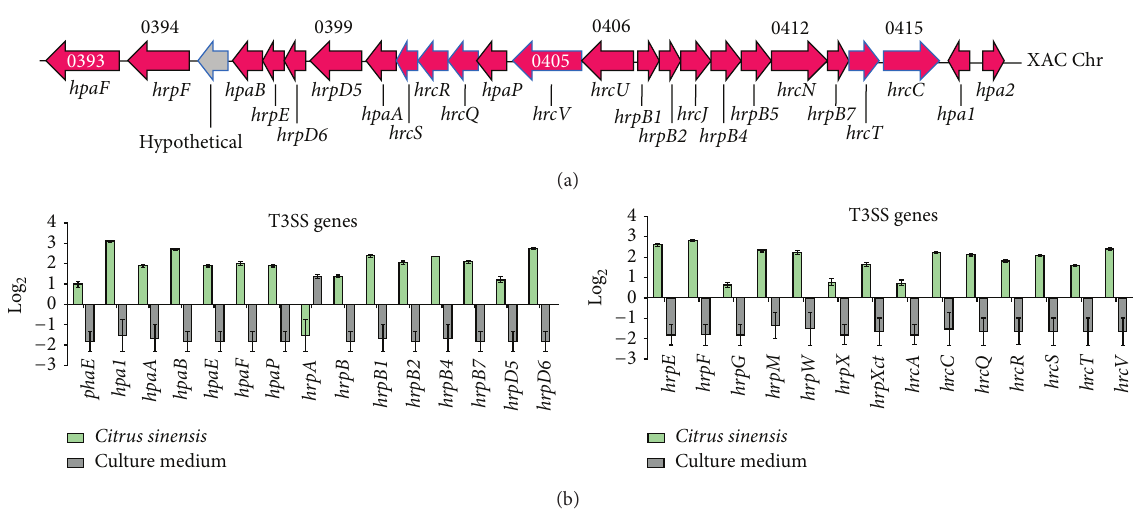
Figure 1: T3SS genes in Xanthomonas citri subsp. citri and their expression levels. Schematic representation of T3SS genes in Xanthomonas citri subsp. citri and their expression levels. (a) shows functional maps of T3SS genes on the chromosome. The expression levels of genes in the T3SS (b) are indicated. Solid green bars indicate in vivo expression with respect to their expression in vitro (black bars). Error bars indicate standard deviation of the replicates.